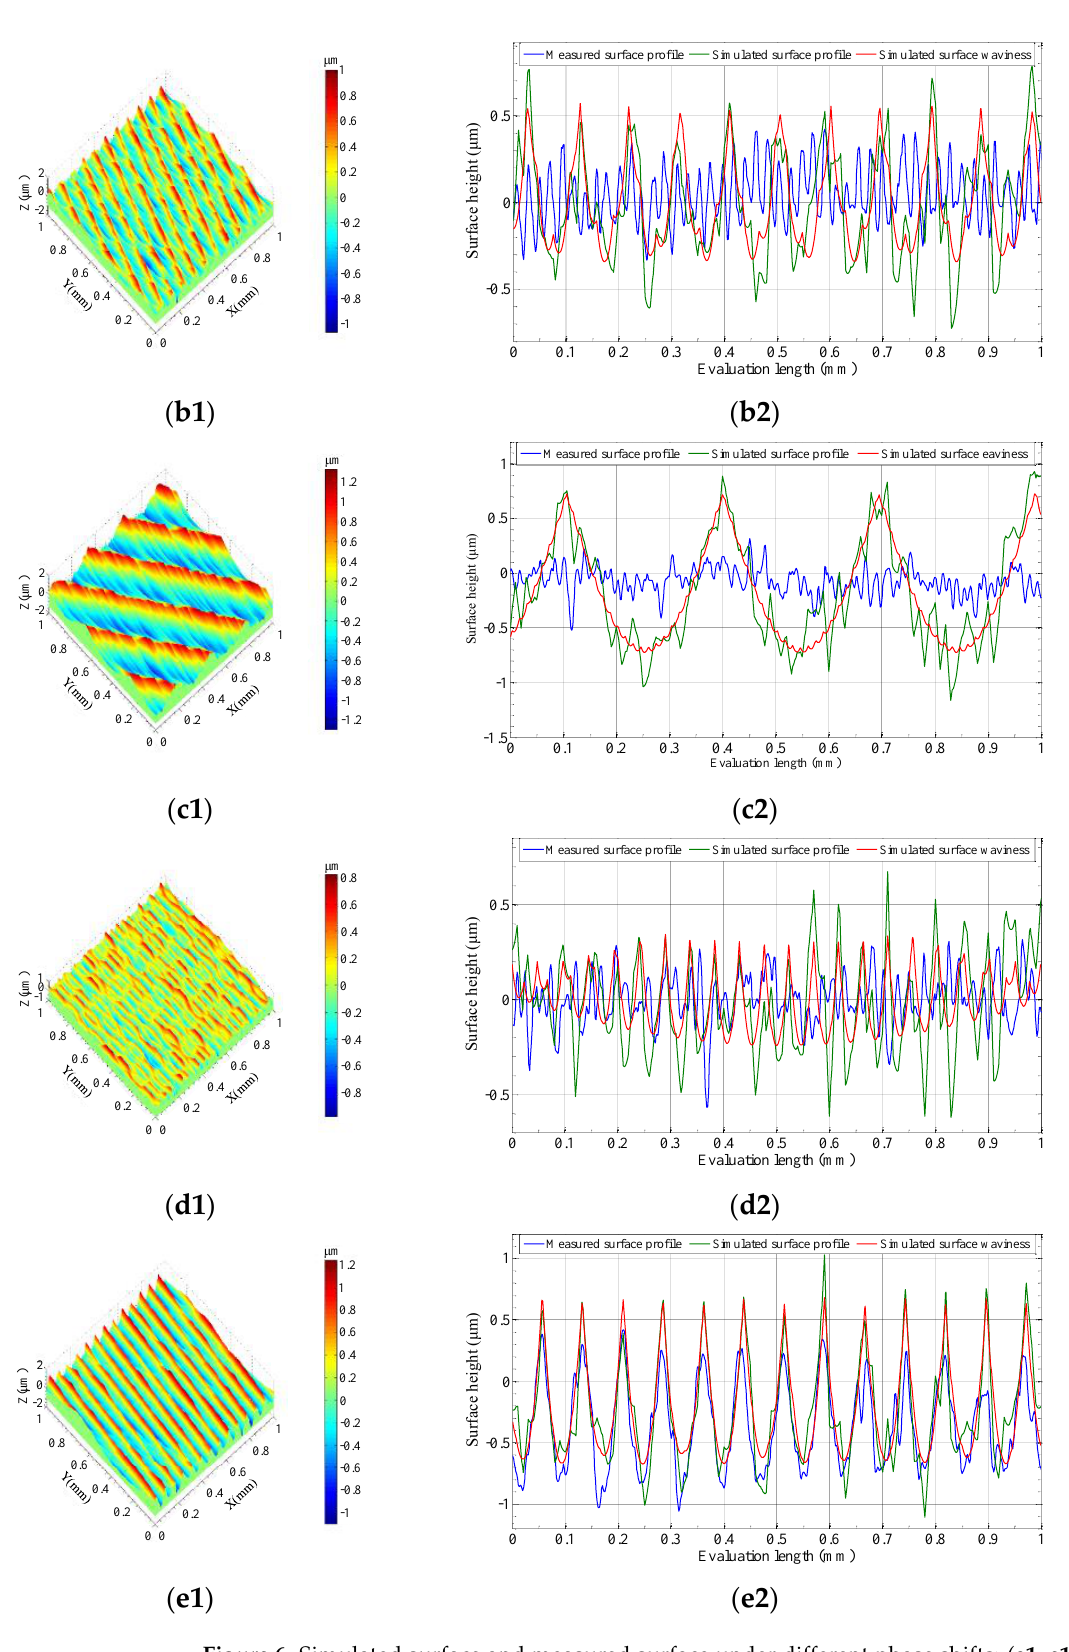
Figure 6. Simulated surface and measured surface under different phase shifts: ( a1 – e1 ) simulated surface topography; ( a2 – e2 ) surface profile